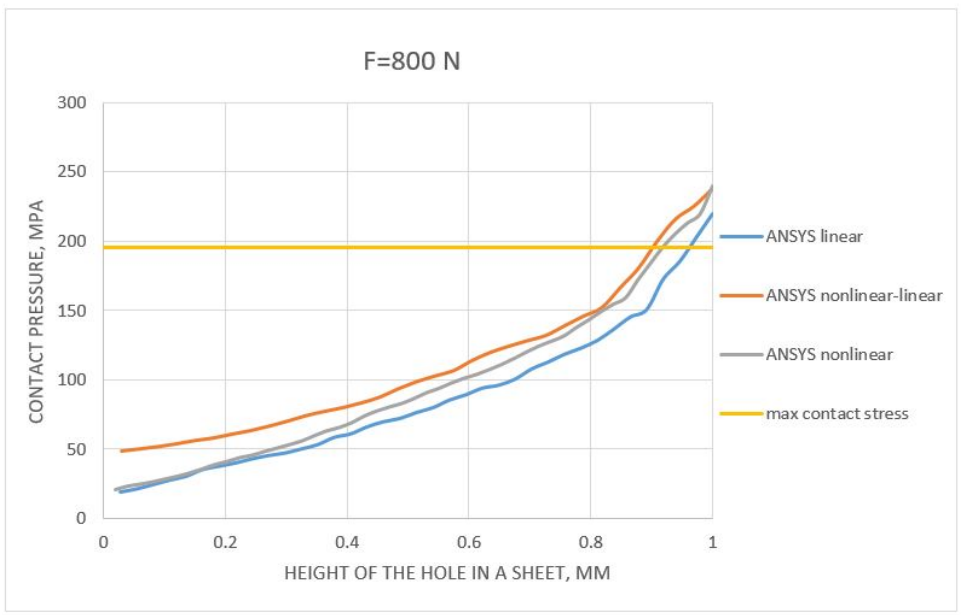
Figure 12. Pressure distribution in contact between the sheet and the skank of the rivet (for a load force F = 800 N).